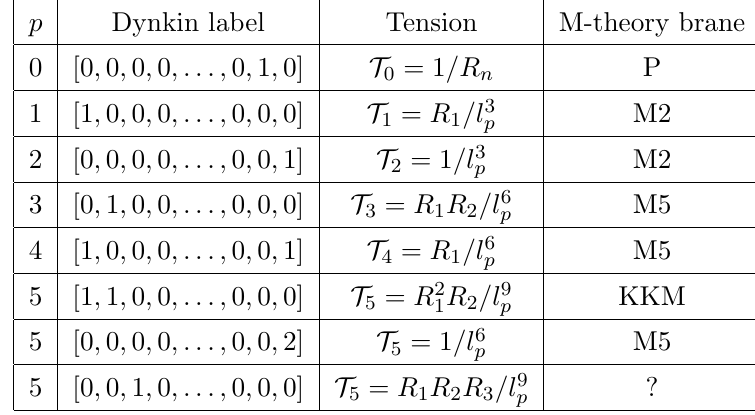
Table 1 . Dynkin labels of the p -brane multiplets, and the tension associated with the highest weight vector and the associated M-theory